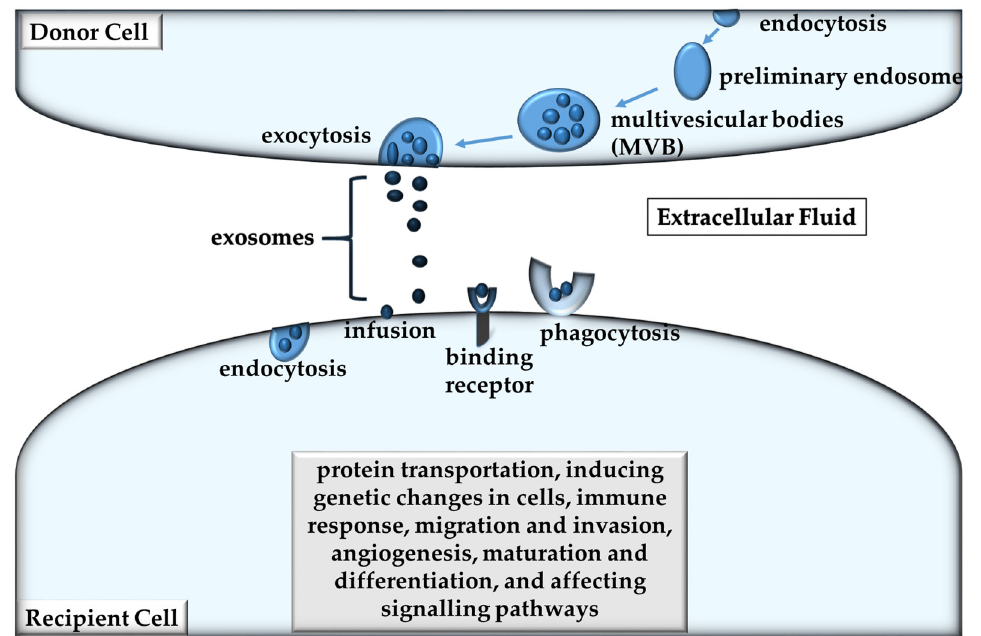
Figure 2. Exosome Biogenesis Process—Endocytes form premature endocytes, which lead to late endocytes or multivesicular bodies (MVBs). Later, exosomes are then released through exocytosis. Exosomes effects on the recipient cell are: protein transportation, inducing genetic changes in cells, immune response, migration and invasion, angiogenesis, maturation and differentiation, and affecting signaling pathways.